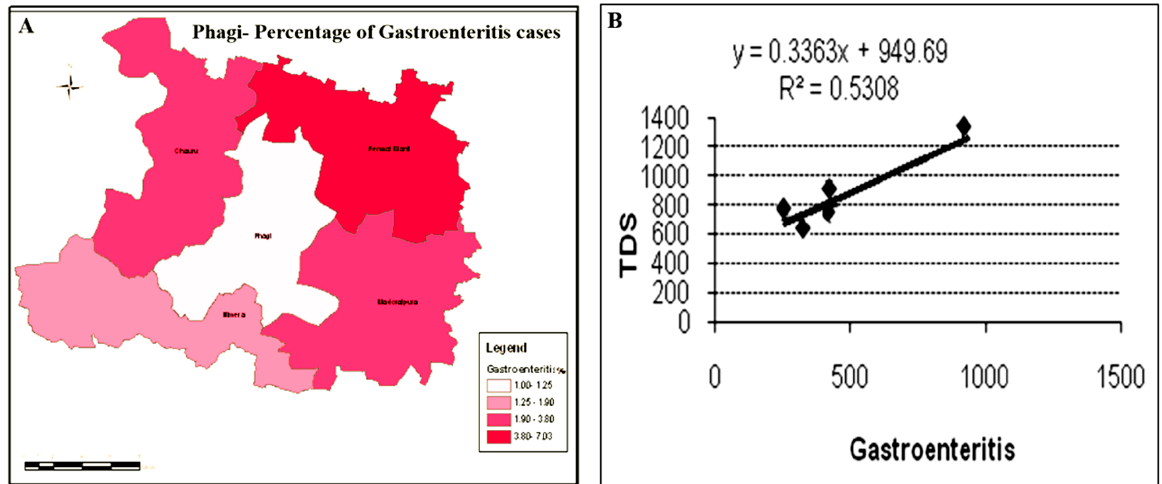
Figure 7. Percentage gastroenteritis incidences cases recorded ( A ); linear regression analysis between gastroenteritis cases and TDS content in water ( B ).